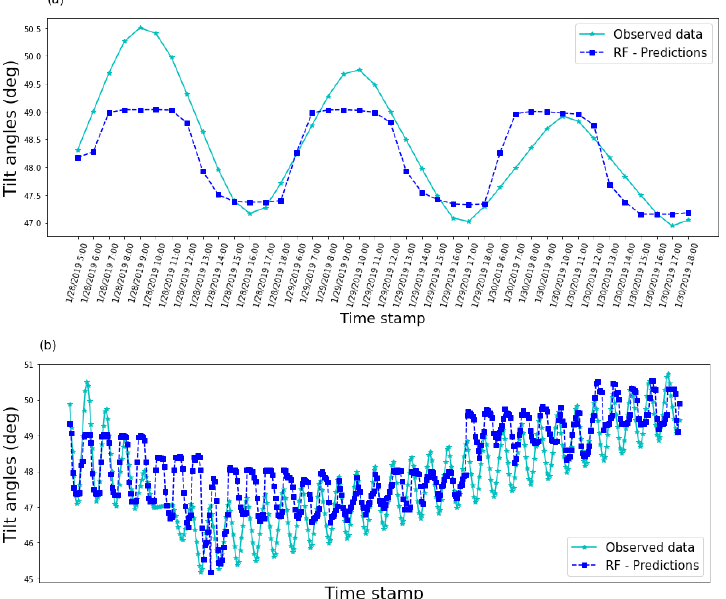
Figure 12. RF prediction results for a random selection of ( a ) 3 days and ( b ) 31 days of the ob- served